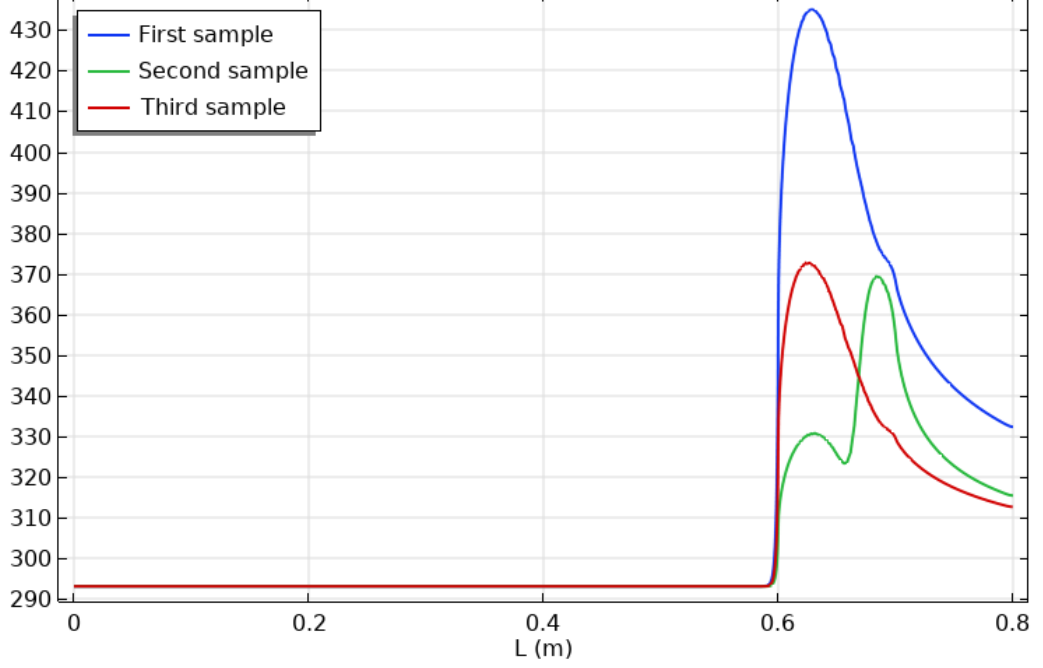
Figure 17. Nusselt number in the channel–enclosure assembly .